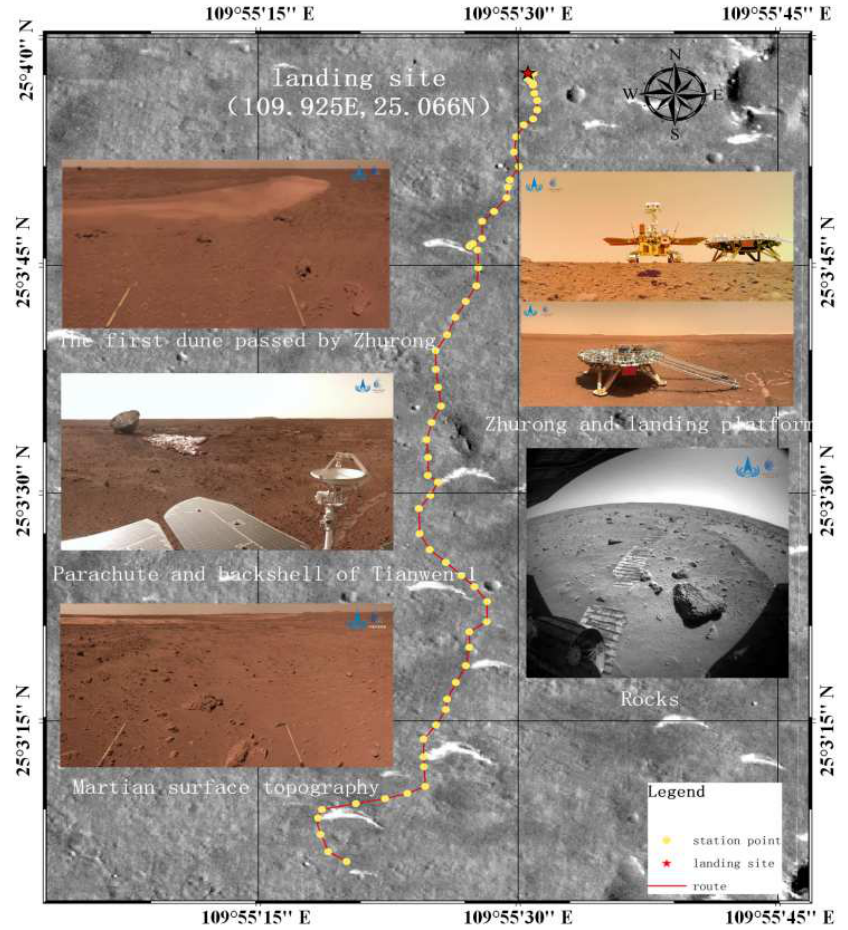
Figure 2. The routing path of Zhurong during its designed life.